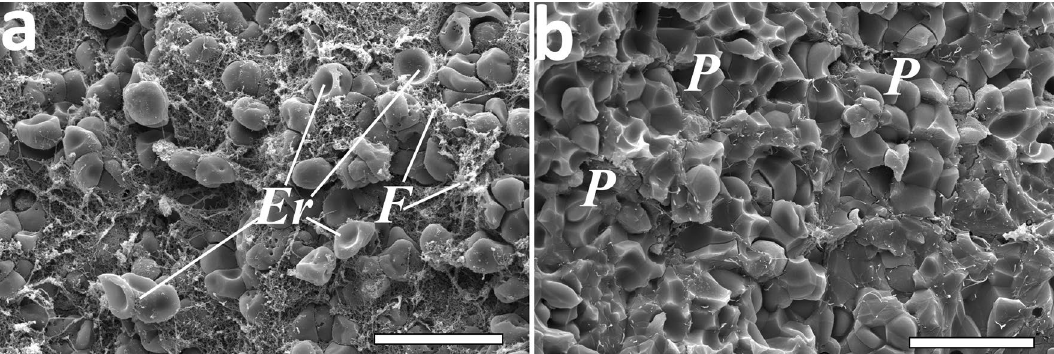
Figure 3. Representative scanning electron micrographs of in vitro blood clots from COVID-19 patients with a low (13%) ( a ) and high (49%) ( b ) extent of clot contraction. Er —partially deformed erythrocytes, F —fibrin, P —fully deformed polyhedral erythrocytes (polyhedrocytes). Magnification bars: 15